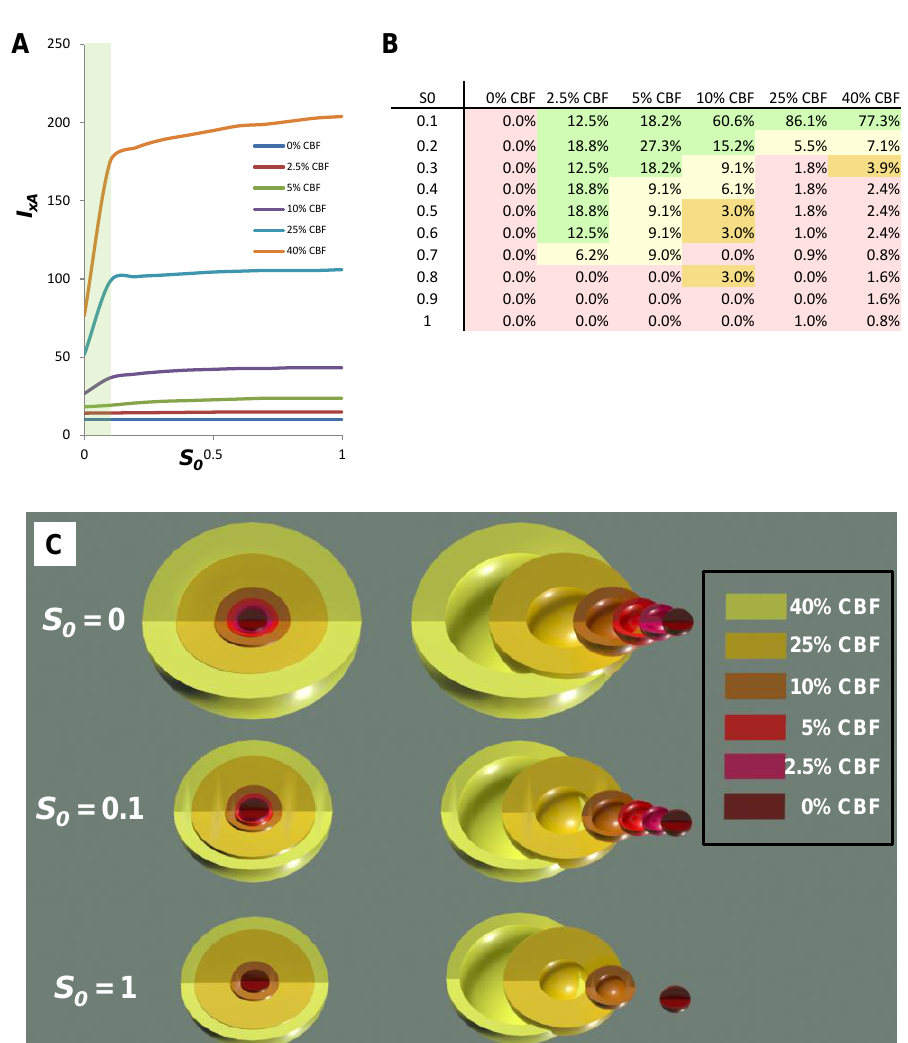
Figure 14. Altered initial conditions across multiple injury courses models stroke neuroprotection. ( A ) Plots of I vs. S at various %CBF levels as indicated. Green area xA 0 marks S ≥ 0.1. ( B ) Table showing change in I as a percent of the total change, with 0.1 0 xA increments in S at the %CBF levels indicated. Green, yellow, orange and red indicate 0 large, medium, small and very small changes, respectively. ( C ) Simple geometrical model of nested concentric spherical shells provides a crude application of the nonlinear dynamical model to stroke injury and stroke neuroprotection. Key indicates correspondence between spheres and %CBF. Top row is untreated case, middle row is 10% of maximal protection ( S = 0.1), and bottom row is maximal protection ( S = 0 0